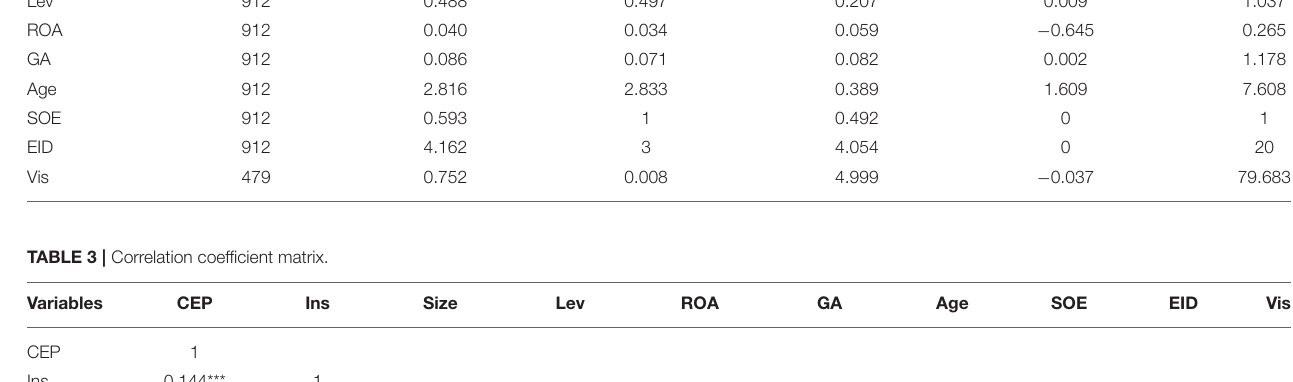
TABLE 3 | Correlation coefficient